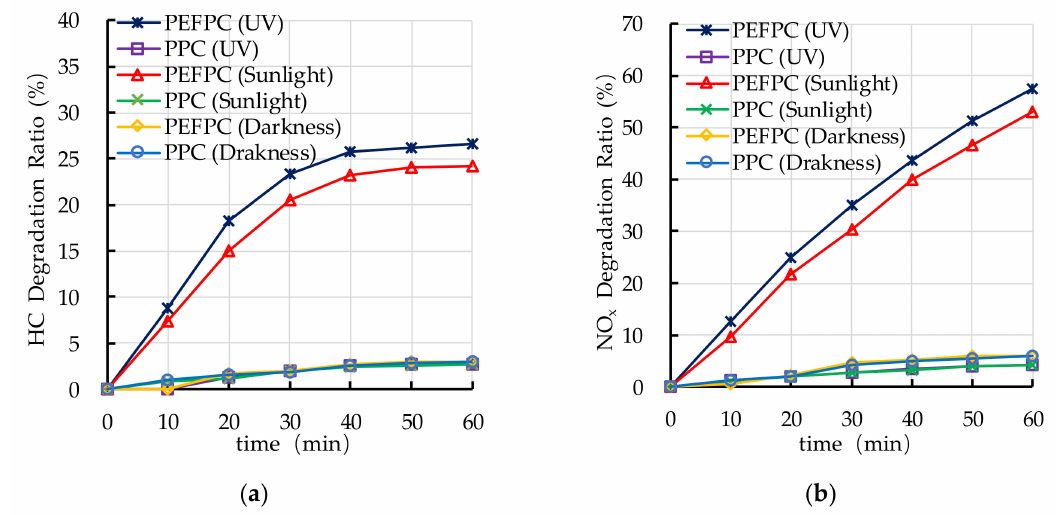
Figure 7. E ff ect of photocatalyst and light source on photocatalytic degradation of hydrocarbons (HC) and nitrogen oxides (NO x ): ( a ) HC degradation ratio; ( b ) NO x degradation ratio.